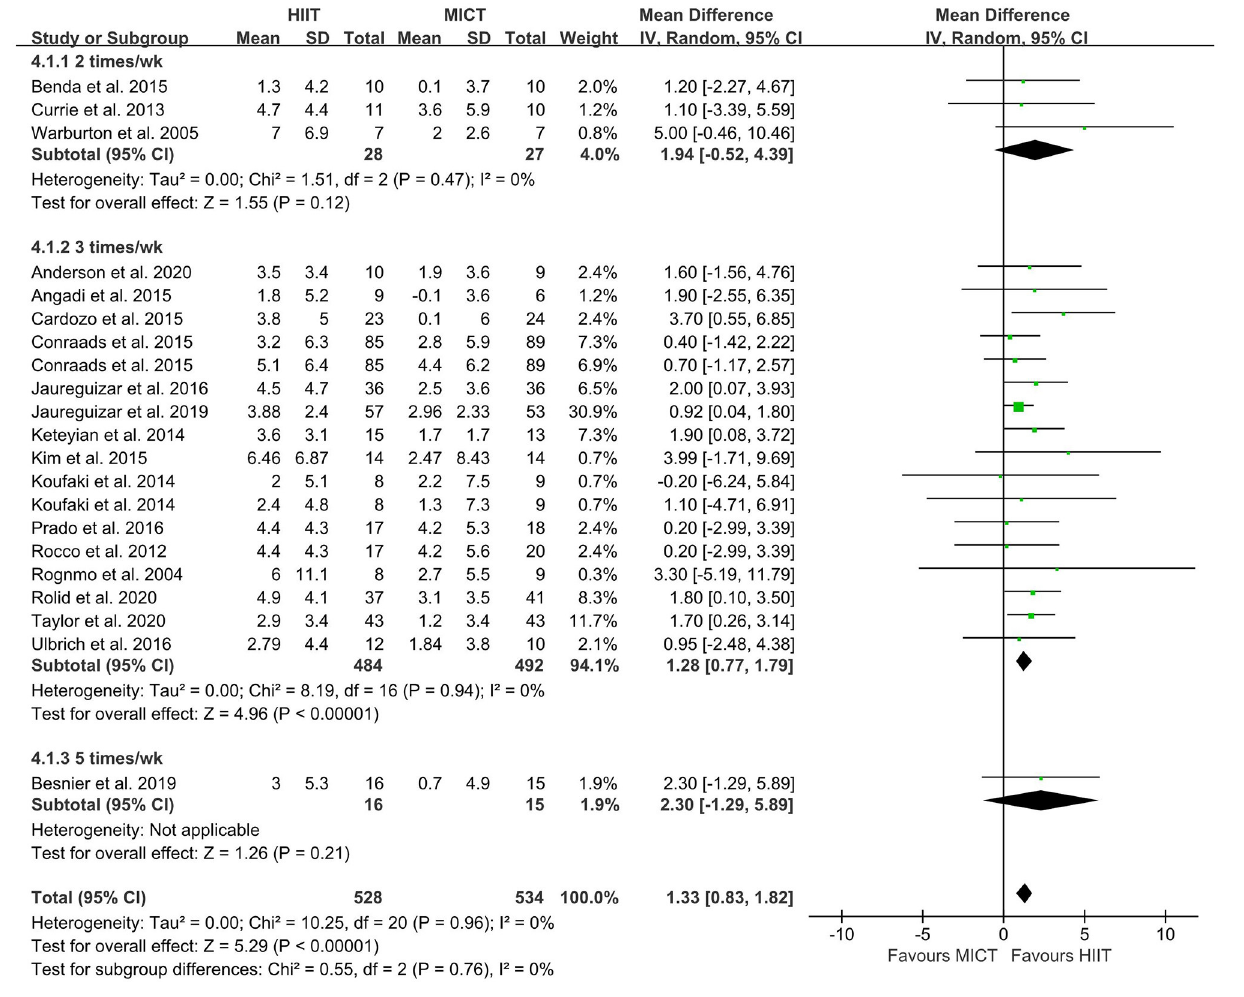
FIGURE 5 | Forest plot of subgroup analysis by different frequencies of HIIT (2 times a week, 3 times a week, and 5 times a week). HIIT, high-intensity interval training; MICT, moderate-intensity